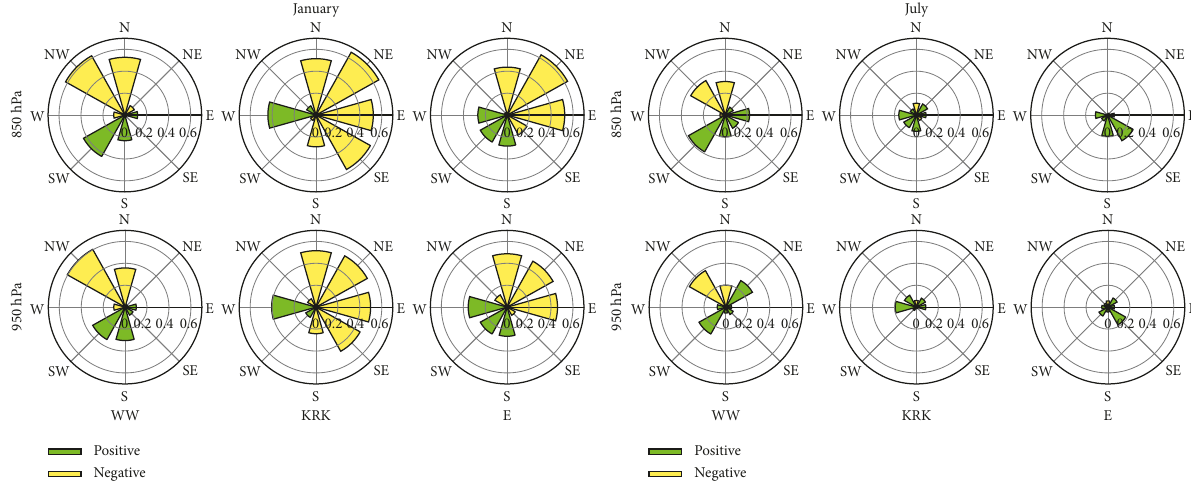
1 m 1 ) in advection directions (with respect to monthly mean, standardized) at selected kg s · · − −